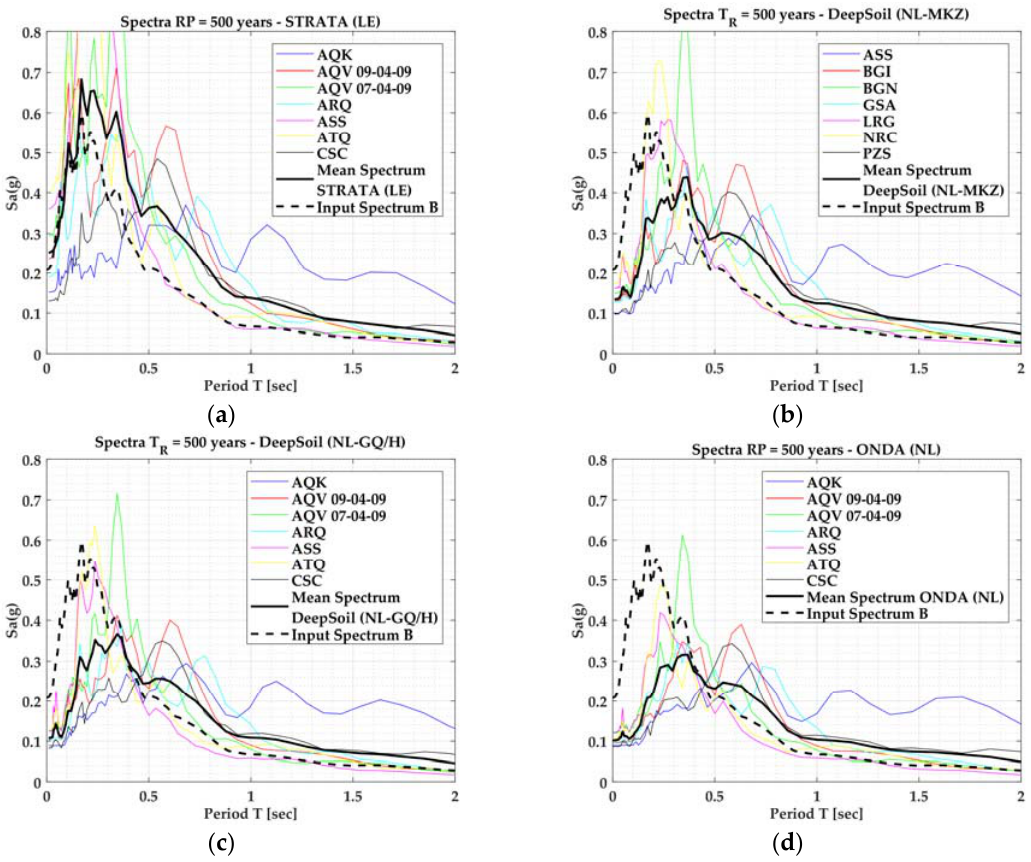
Figure 14. Results of SRA for return period = 500 years with: ( a ) STRATA (LE); ( b ) DEEPSOIL (NL ‐ MKZ); ( c ) DEEPSOIL (NL ‐ GQ/H); ( d ) ONDA (NL).